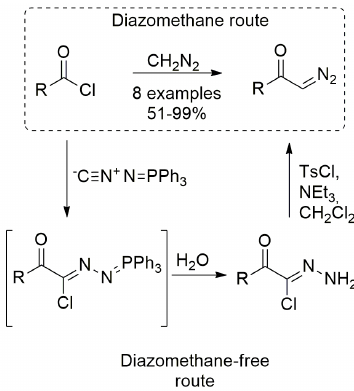
Figure 35- Diazomethane-free conversion of acyl chlorides to